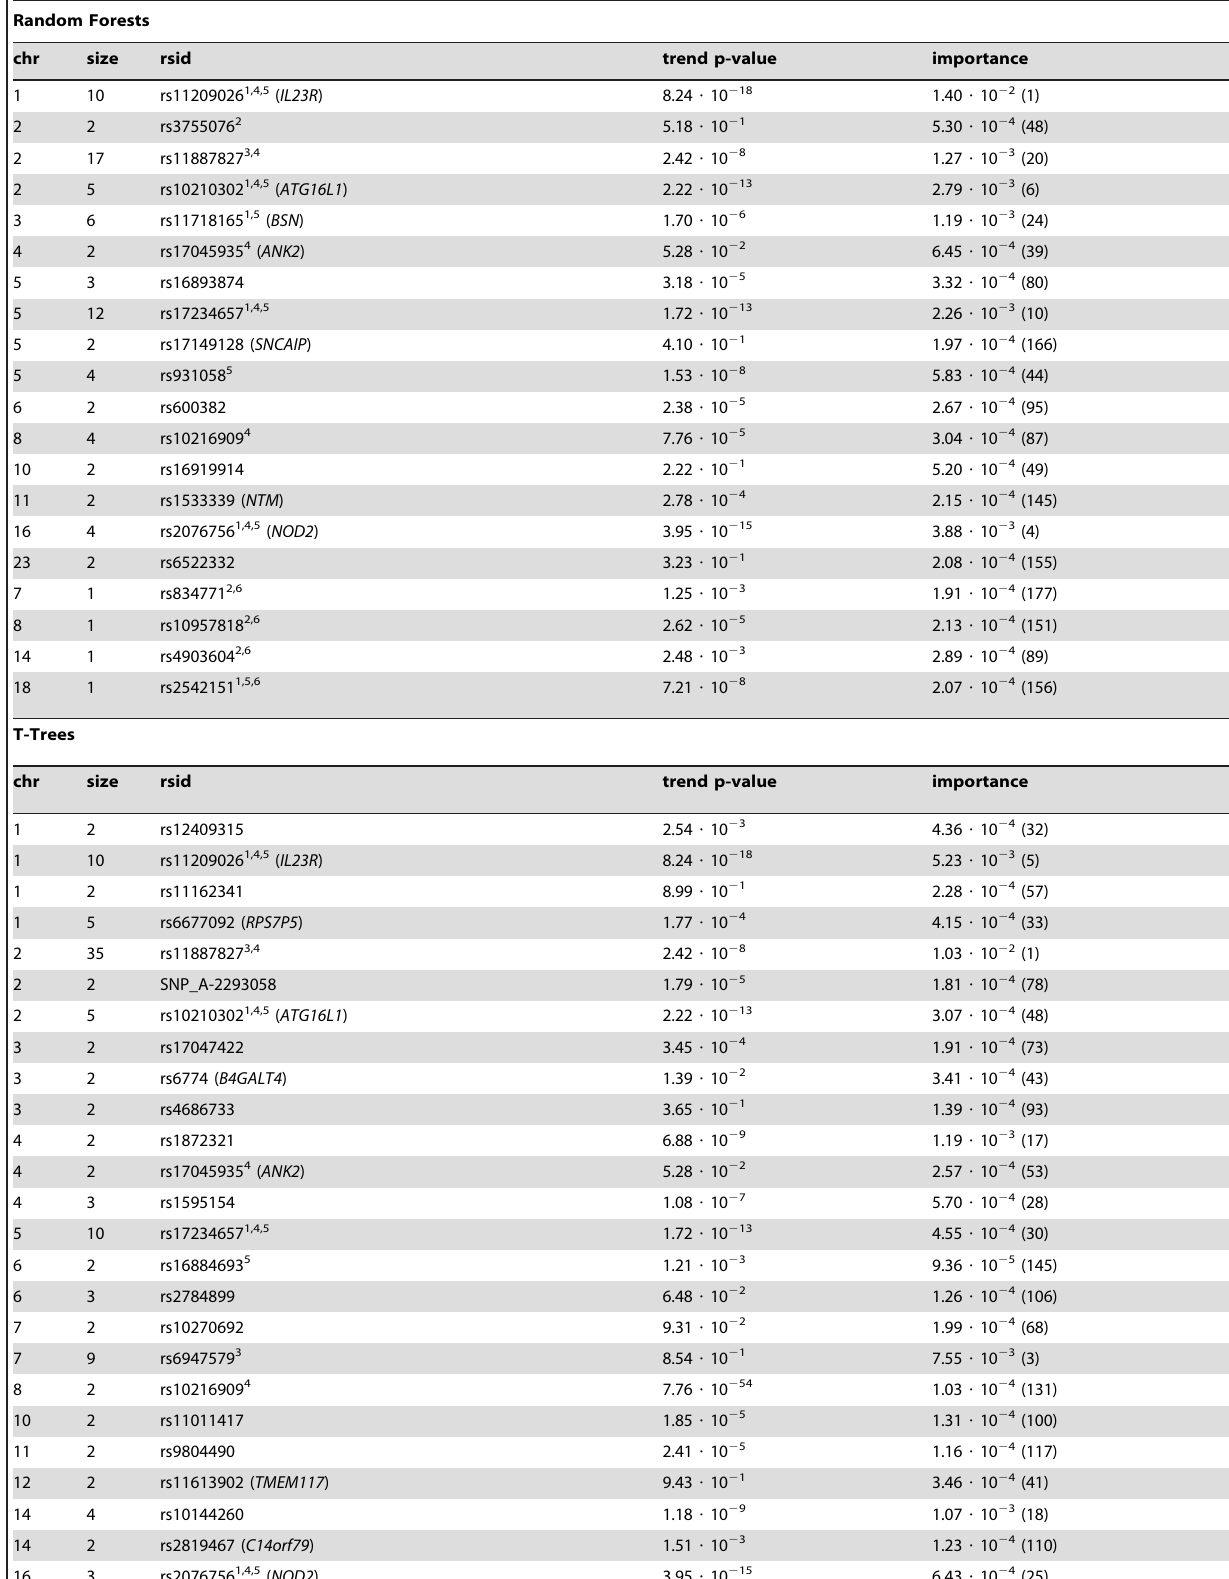
Table 6. Regions highlighted from the top 200 SNPs according to SNP importances with RF and T-Trees on CD qc .